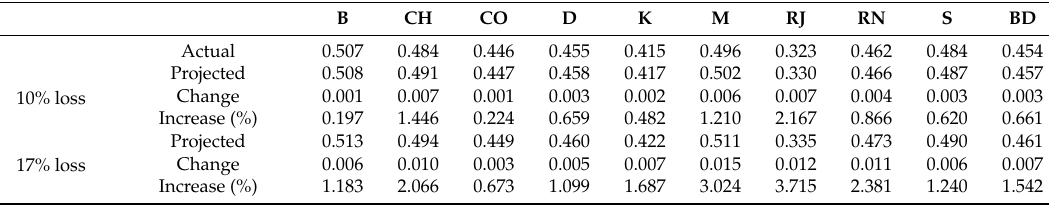
Table 12. Change in poverty rate following a loss of rice yield due to climate change. B CH